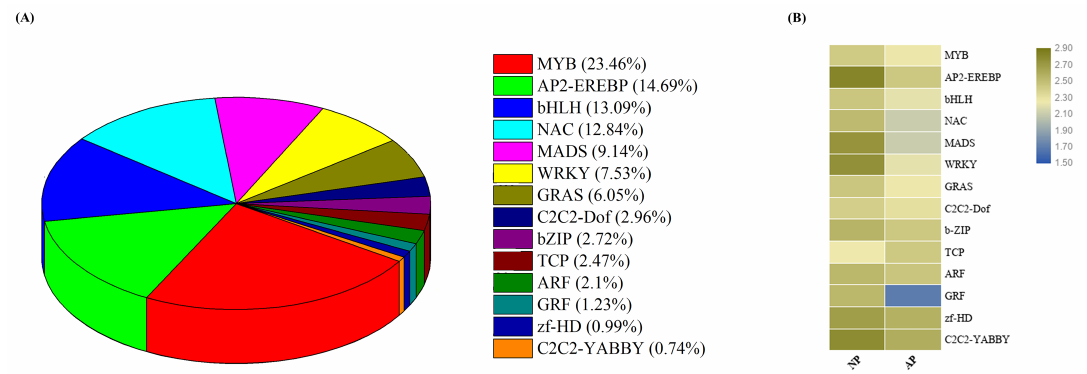
Figure 3. This is a figure, Schemes follow the same formatting. If there are multiple panels, they should be listed as: ( a ) Description of what is contained in the first Figure 4. Analysis of transcription factors (TFs) between normal and abortive pistils of Japanese panel. ( b ) Description of what is contained in the second panel. Figures should be placed in the main text near to the first time they are cited. A caption on a single line apricot. ( A ) Distribution of important TF families and their percentage of genes in each TF family. should be centered. ( B ) Average expression profiles of genes involved in each TF family in normal and abortive pistils. The bar represents the scale of expression of each gene as indicated by blue (lower expression) and dark yellow (higher